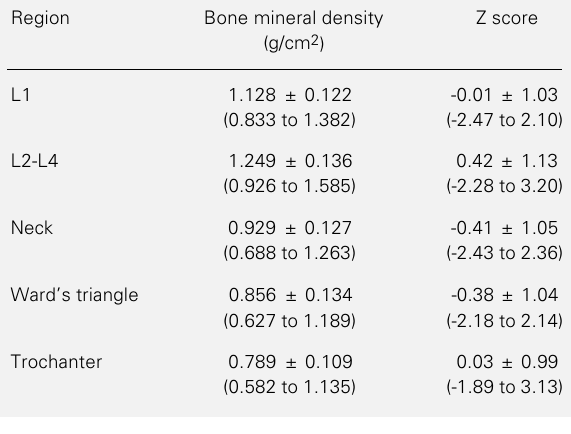
Table 1 - Bone mineral density and Z scores of premenopausal women. Data are reported as means ± SD (range) for 60 subjects.